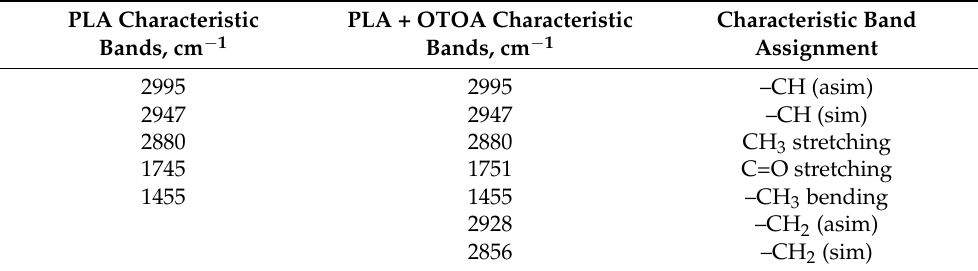
Table 3. Characteristic bands in the FTIR spectra of PLA and PLA + OTOA fiber